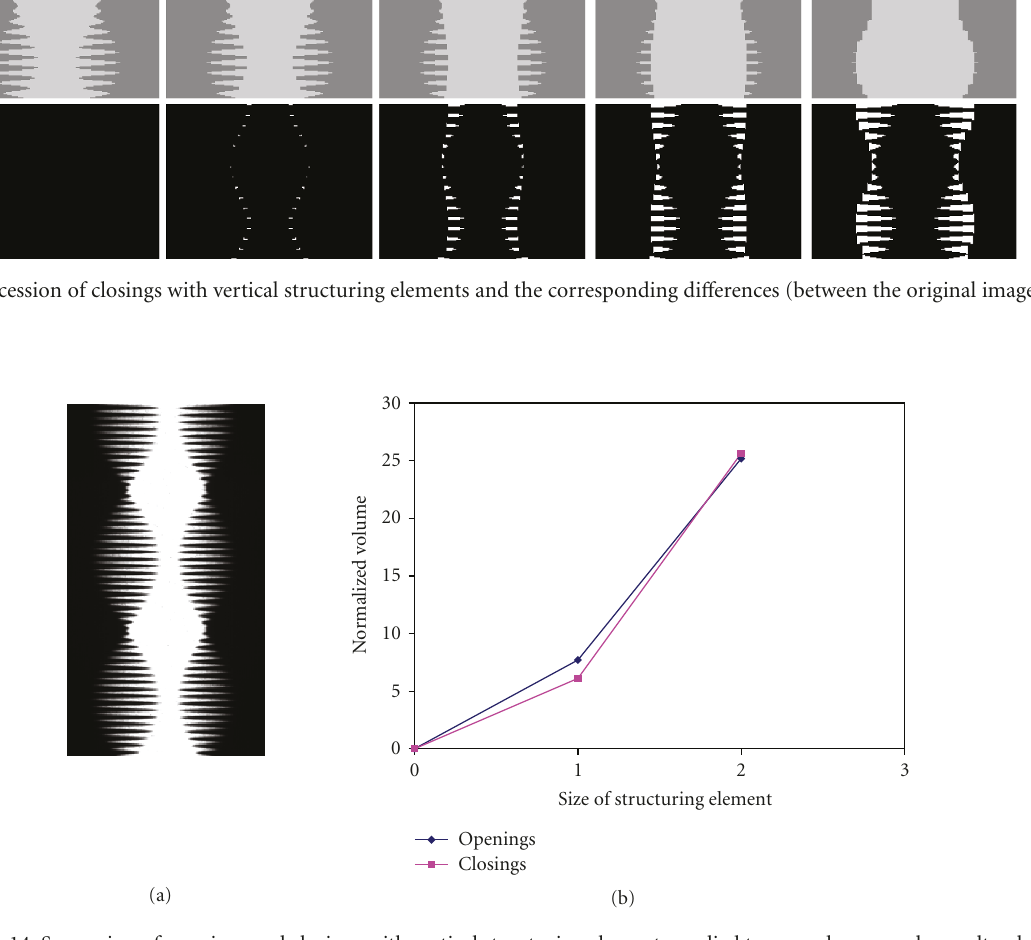
Figure 14: Succession of openings and closings with vertical structuring elements applied to an underexposed